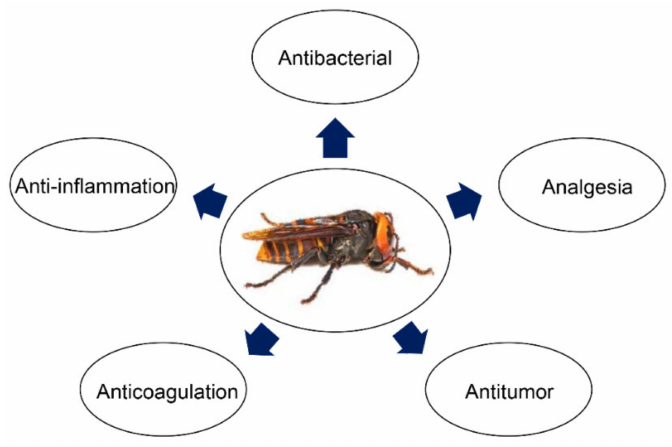
Figure 2. The pharmacological activity of bioactive peptides from wasp